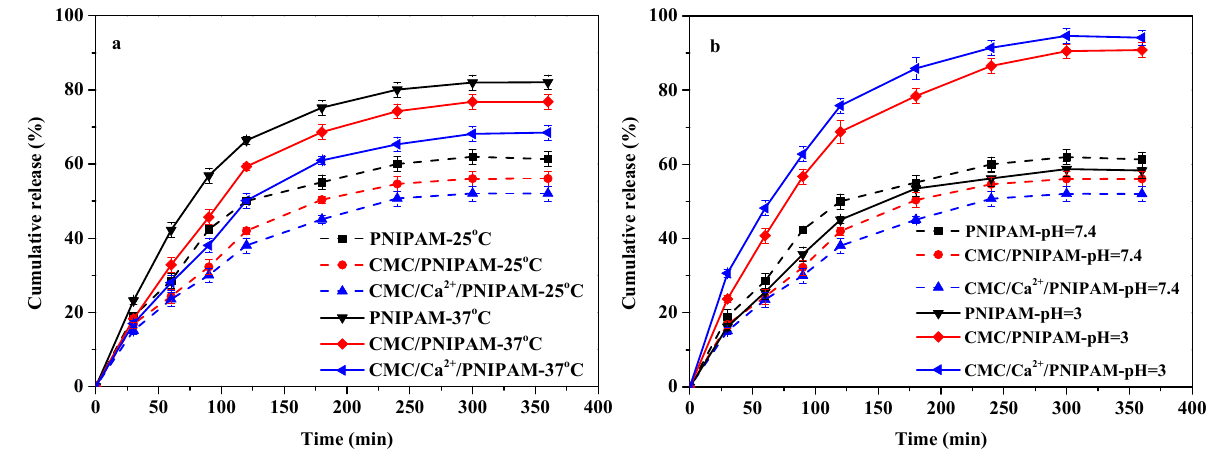
Figure 5. ( a ) Effect of temperature on drug release; ( b ) effect of pH on drug release.